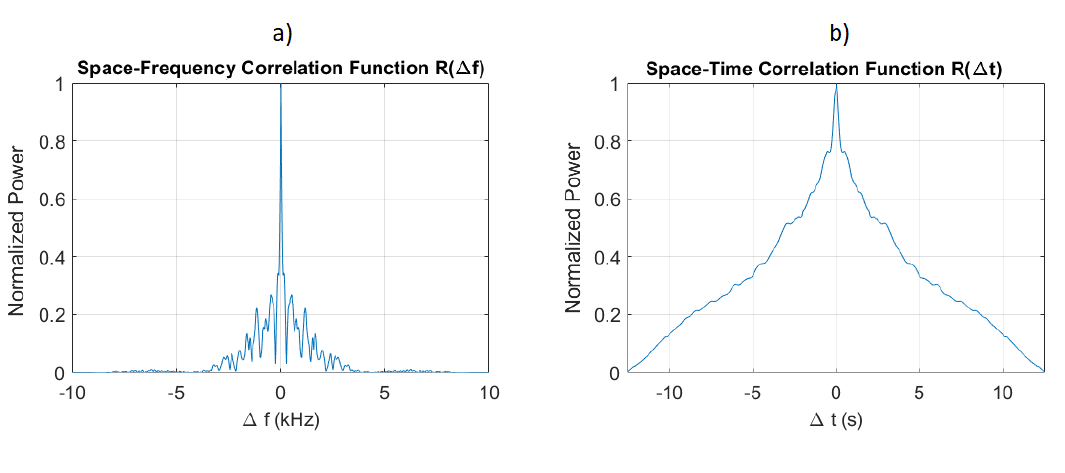
Figure 5. Power Delay Profile ( a ) and Doppler Power Spectral Density ( b ) of the measured UAC channel at a distance of 1035 m.